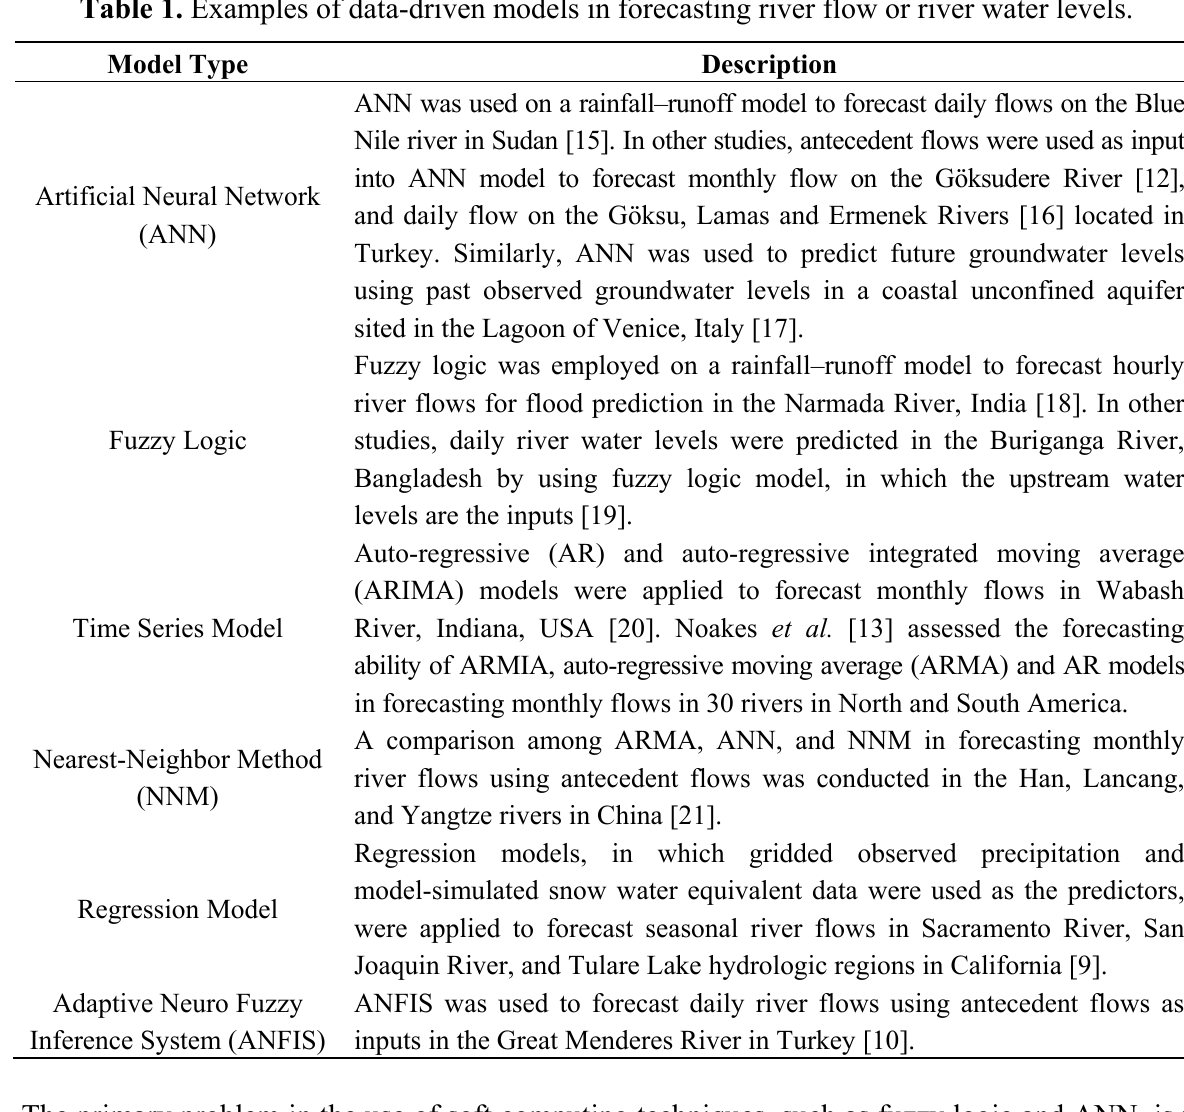
Table 1. Examples of data-driven models in forecasting river flow or river water